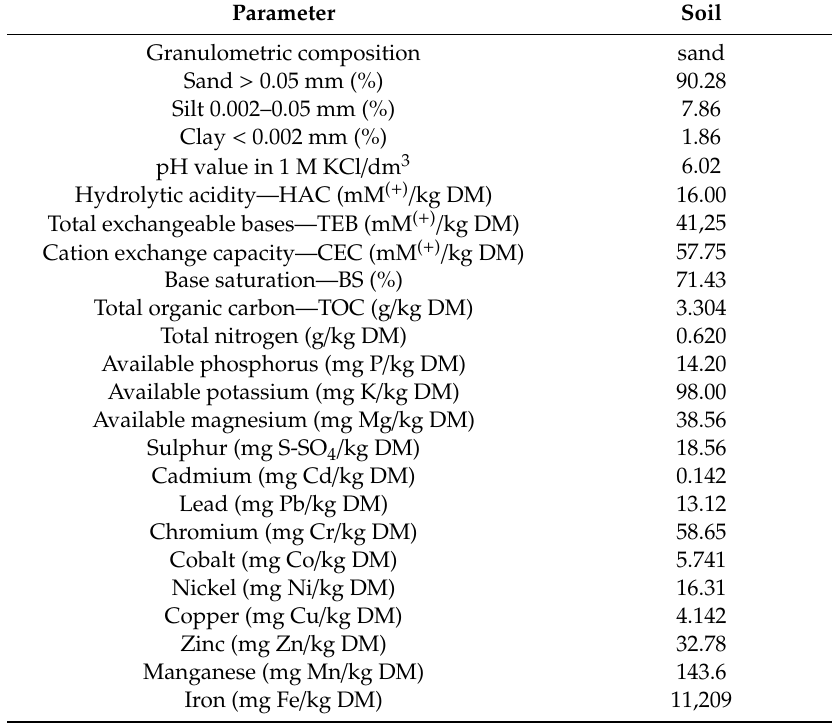
Table 1. Properties of